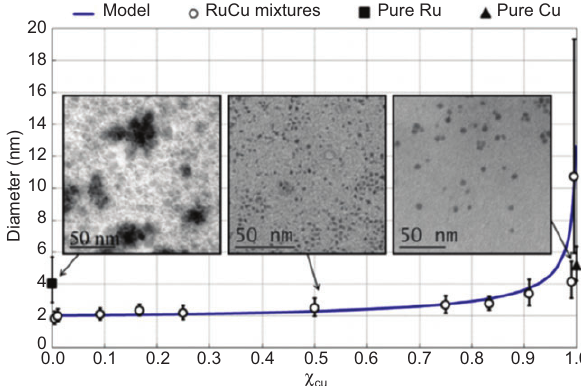
Figure 4 Size evolution of Ru-Cu bimetallic NPs with initial compo- sition of the solution. The size of Ru-Cu NPs (white circles) is plotted as a function of the molar fraction of Cu ( χ ) in solution and compared with pure Ru Cu and pure Cu. Error bars correspond to ± 2 standard deviations in the log-normal distribution. The solid line represents the size evolution expected from the formation of core-shell NPs with a 2 nm core of Ru and a shell of closely packed Cu. TEL images of χ values 0, 0.5, Cu and 1 are also shown. © Elsevier [19]